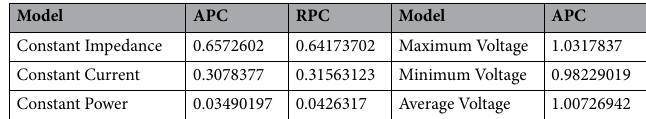
Table 5. Caraguay ZIP static load model coefficients and voltage bus